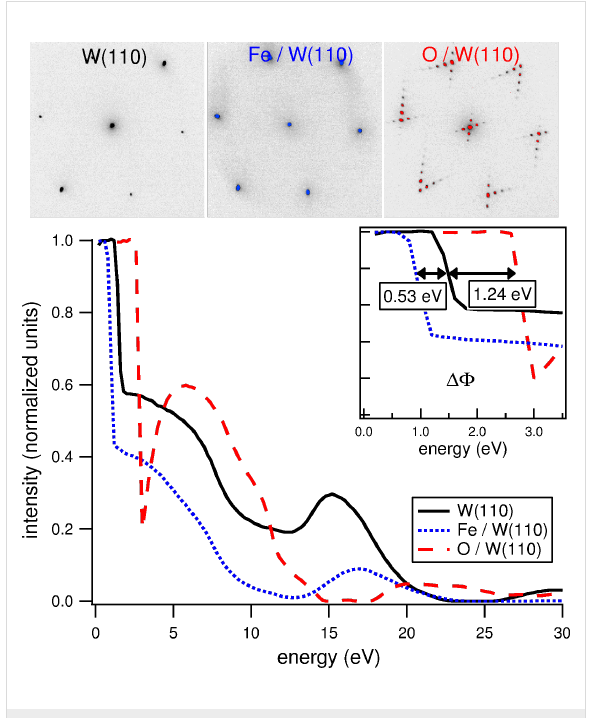
Figure 2: Energy dependence of the (00) beam intensity for clean, Fe-covered and O-covered W(110) surfaces. The top panels show the respective LEED patterns. The inset is a blowup of the MEM–LEEM transition at low energy. The increase (decrease) in the work function due to the presence of O or Fe is seen in the shift of the transition